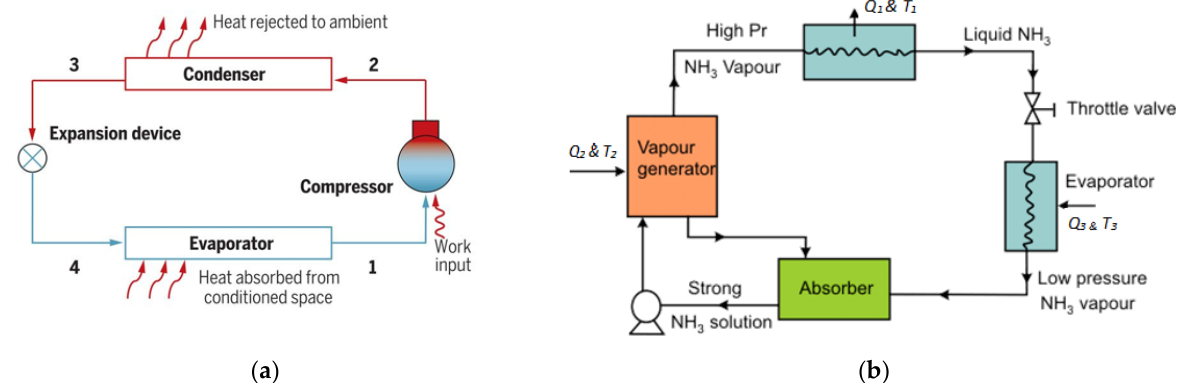
Figure 1. Technology options for cooling ( a ) Vapor compression cooling ( b ) Vapor absorption cooling.